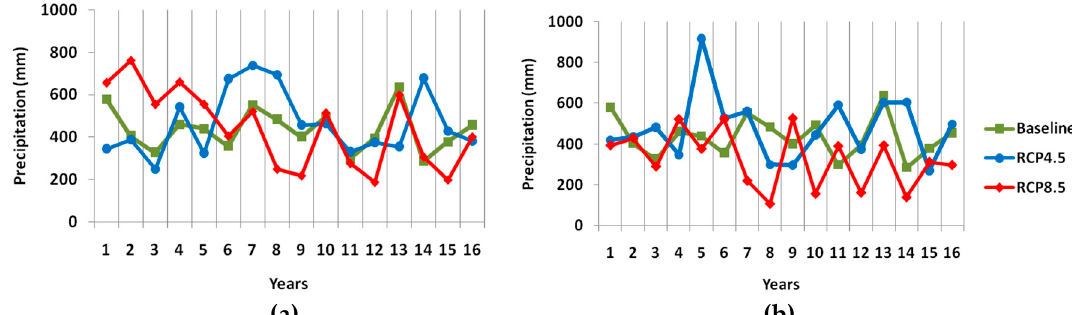
Figure 7. Annual distribution of mean precipitation averages under both RCPs during ( a ) 2035–2050 and ( b ) 2085–2100 periods in comparison to baseline (1990–2005).